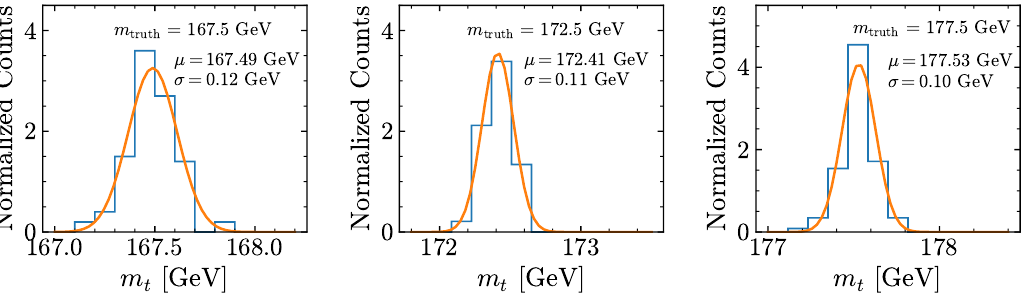
Figure 17 . Di-leptonic template closure tests for m t =167.5 GeV, 172.5 GeV and 177.5 GeV. The distribution of bootstrapped results are given by the histogram, along with an accompanying Gaus- sian (cid:12)t, whose mean and standard deviation are inset within each